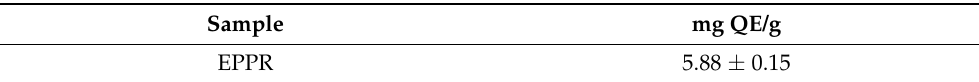
Table 1. Mean ± standard deviation of the flavonoid content in EPPR. Results expressed in mg of quercetin equivalent per gram dry weight of the extract (mg